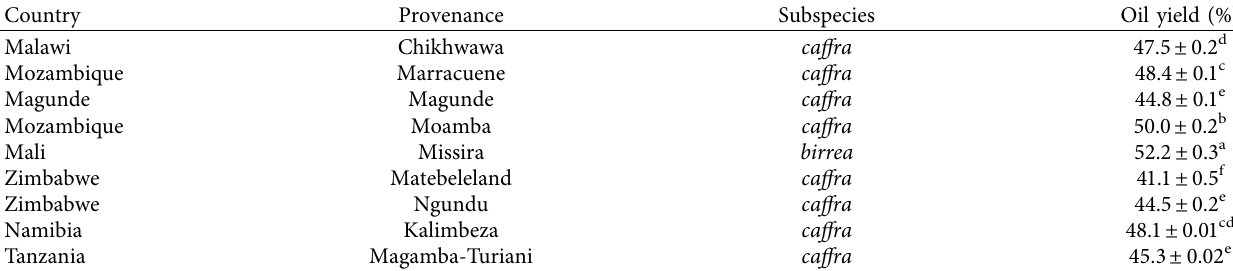
Table 1: Yield of Sclerocarya birrea (subspecies cafra and birrea) seed oil among nine provenances.